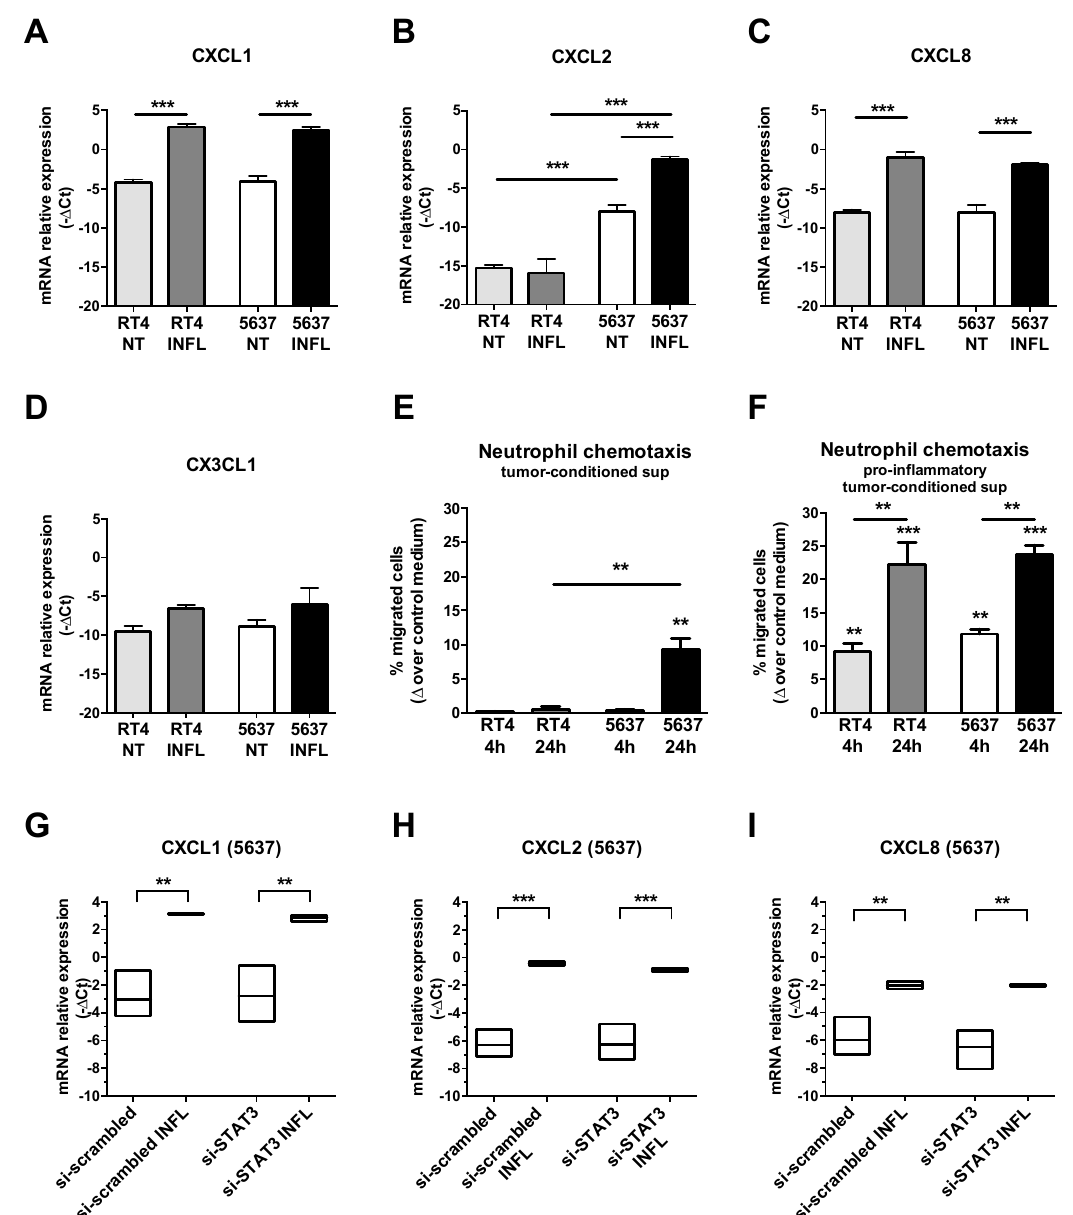
Figure 10. Modulation of TAN-attracting CK in UBC cell line. Column bars ( A – D ) showing the mean ± SD of CKs mRNA relative gene expression (- ∆ Ct, n = 3), measured by qRT-PCR in luminal-type RT4 and basal-type 5637 UBC cell lines. After stimulation with a cocktail of proinflammatory cytokines, a significant induction of the CXCL1 and CXCL8 mRNA ( A , C ) is observed in both UBC cell lines. CXCL2 is significantly enriched in basal-type 5637 UBC cell line compared to luminal-type RT4 cells both at resting and after stimulation ( B ). Column bars ( E , F ) showing neutrophil chemotaxis towards tumor-conditioned supernatants from luminal-type RT4 or basal-type 5637 UBC cell lines untreated ( E ) or stimulated for 4 or 24 h with a pro-inflammatory cytokine cocktail ( F ) ( n = 3). Chemotaxis is reported as increased percentage of migrated cells (expressed as % of total cell input, mean ± SD) induced by tumor-conditioned supernatants over the control medium. Floating bars ( G – I ) showing that CKs’ mRNA is not modulated by siRNA STAT3 in 5637 cell line stimulated with pro-inflammatory cytokine cocktail (mean, range; n = 3). A one-way ANOVA test was used for all statistical analysis and pairwise comparisons p values were adjusted for multiple comparisons; significant results were showed (* p < 0.05, ** p < 0.01, *** p < 0.001). INFL, with the pro-inflammatory cytokine cocktail (TNF-a, IL6, IL1b); supernatants, sup.